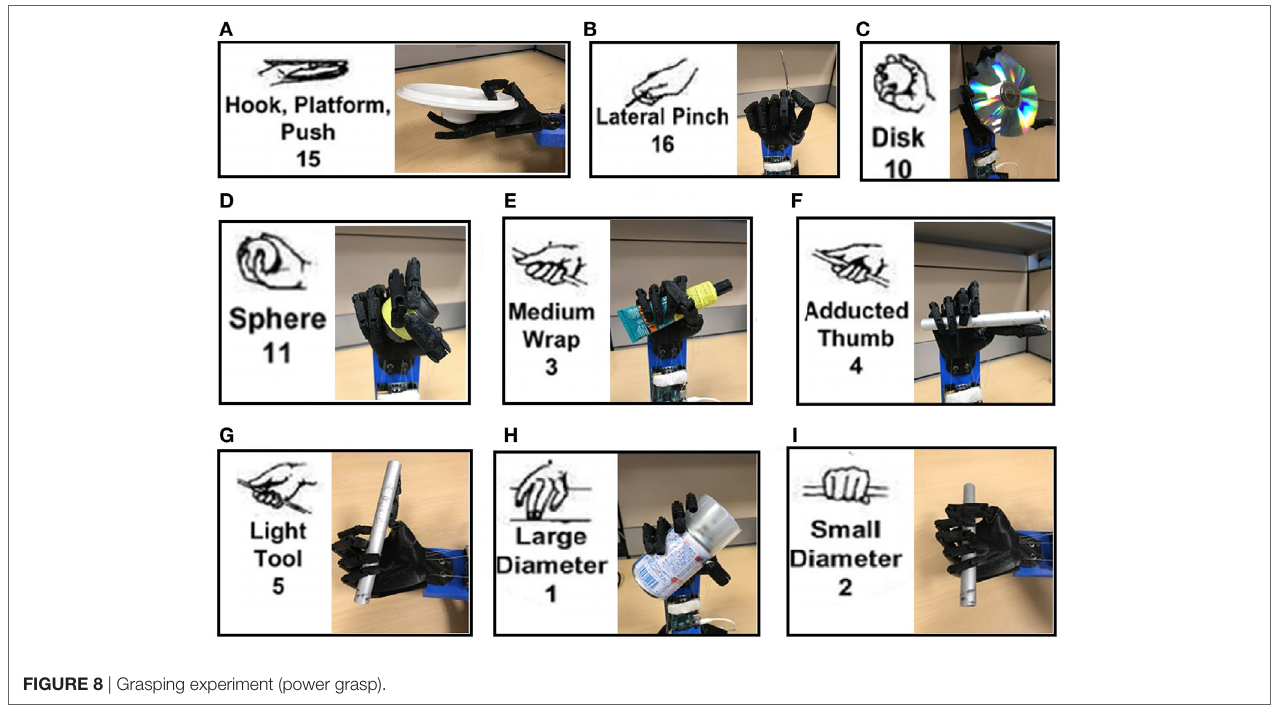
FigUre 8 | Grasping experiment (power grasp).